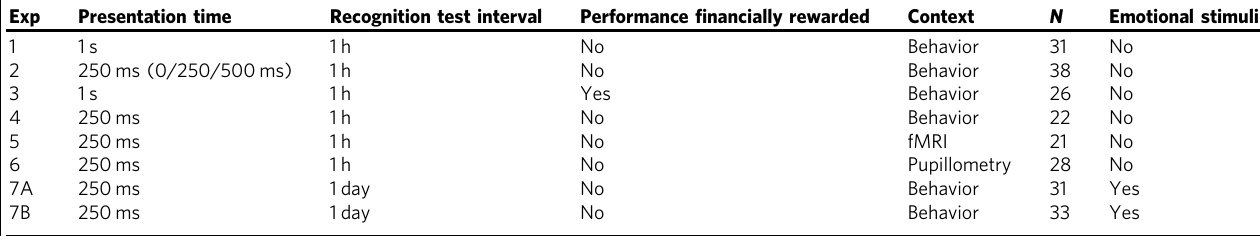
Table 1 Summary of experimental protocol